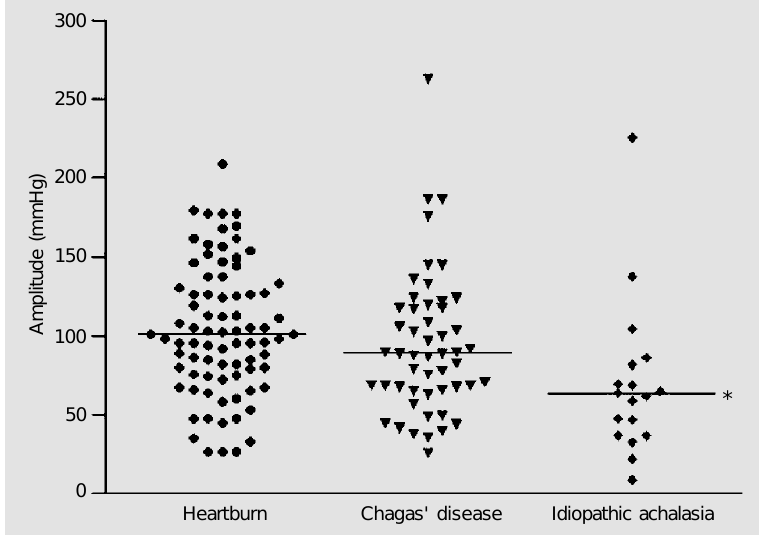
Figure 1. Amplitude of esophageal striated muscle contractions in patients with heartburn, Chagas’ disease or idiopathic achalasia. The horizontal lines indicate the medians. *P<0.01 compared to heartburn (Tukey-Kramer test).